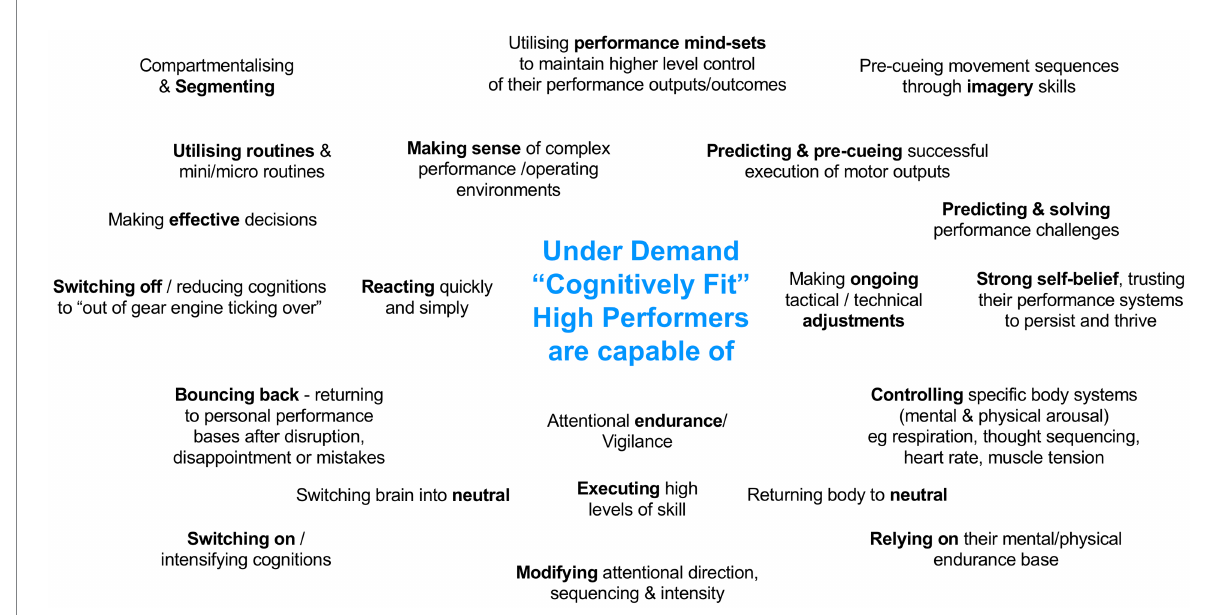
FIGURE 2 Functional capabilities of high performers (adapted from Crampton et al.,